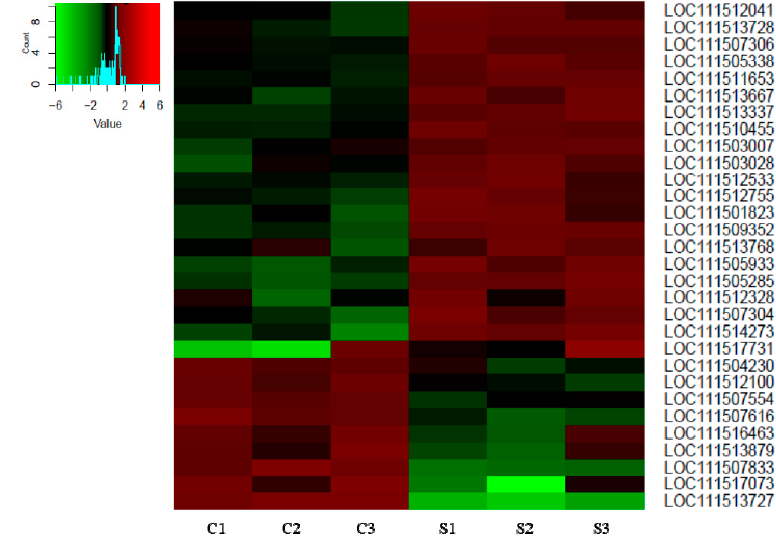
Figure 1. Heatmap showing the most differentially expressed transcripts in control (C) insects versus insects treated with spinosad (S) as measured by NGS. Accession numbers for transcripts that showed absolute log2 fold-changes greater than 1.0 and p values lower than 0.05. Table 2. Modulation of 30 mRNA transcripts in spinosad-treated L. decemlineata . Accession numbers, name of transcripts and changes in expression levels for spinosad-modulated transcripts identified by